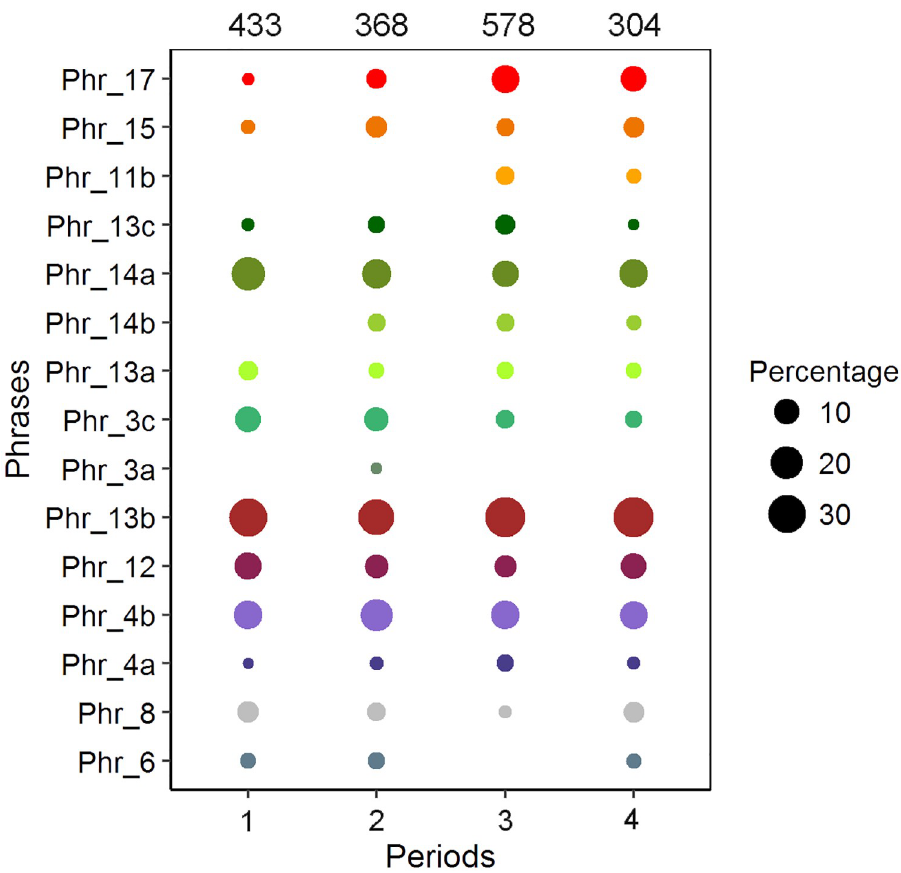
Fig 6. Percentage of phrase occurrence. Percentage of phrase occurrence within the songs per period. The size of the filled circles represents the prevalence of the phrases during each period, i.e. the larger circles represent greater prevalence of each particular phrase. The values above each period column represents the phrase sample size for each period (n).